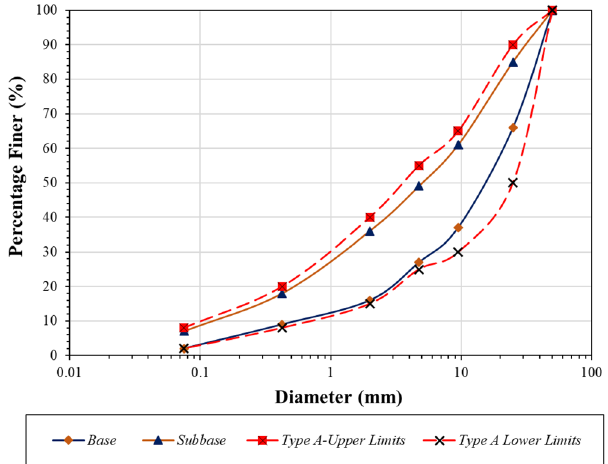
Figure 2. Based on the AASHTO Guide for Pavement Structures, grain diameter distributions were prepared for subbase and base